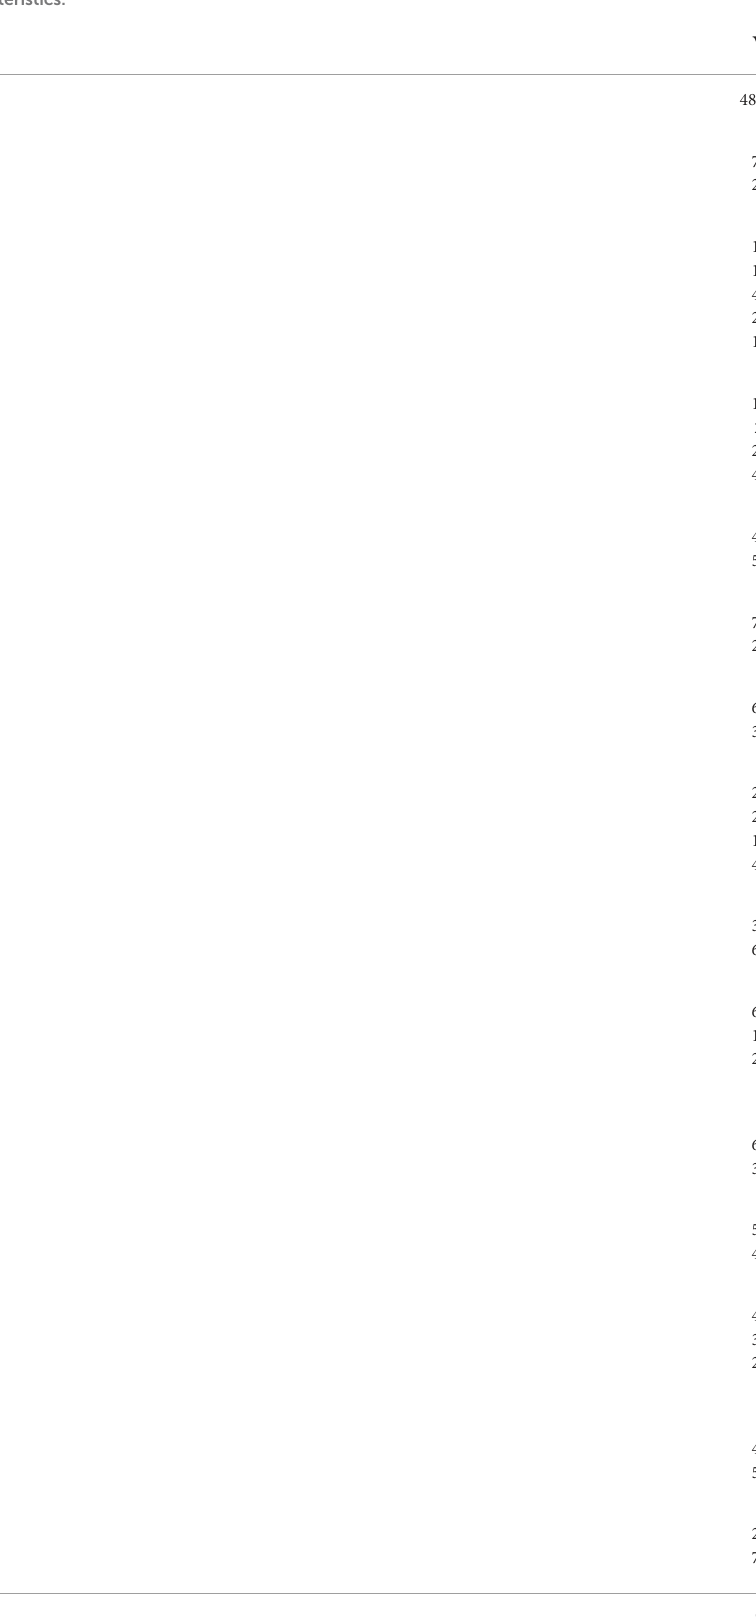
TABLE 1 Patient and transplantation